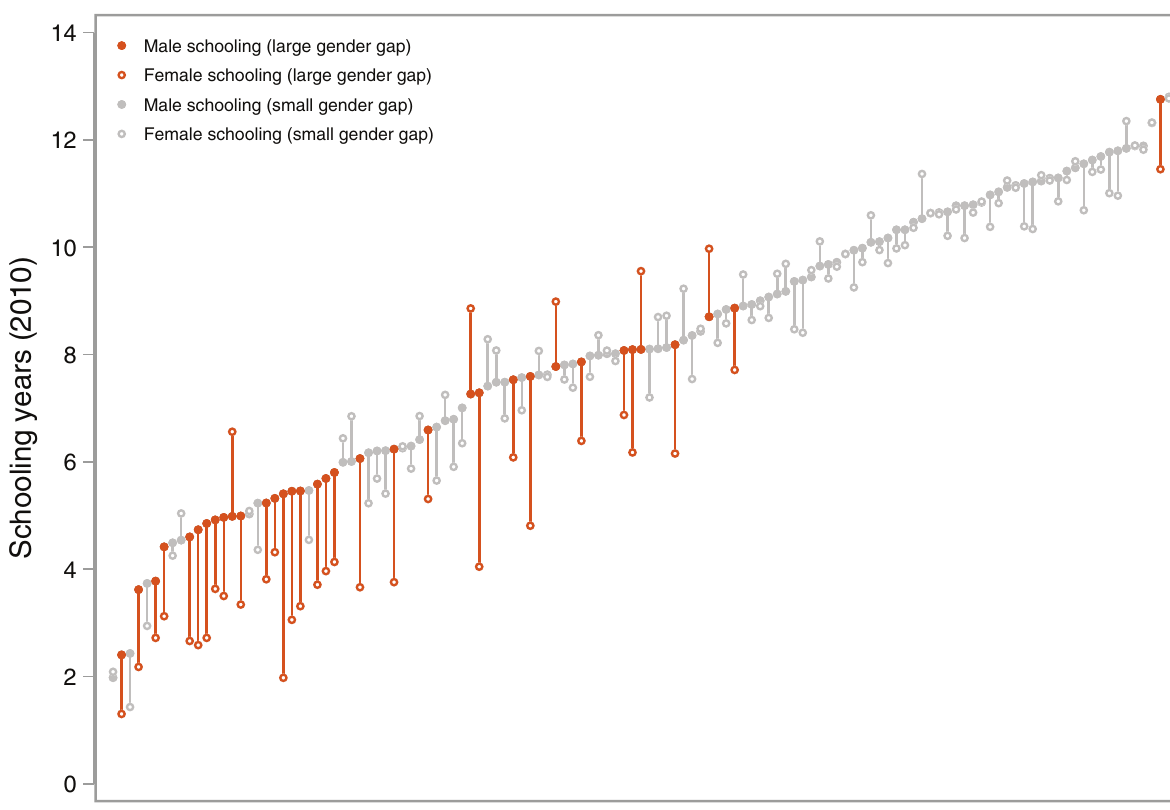
Figure A3 Schooling Years and